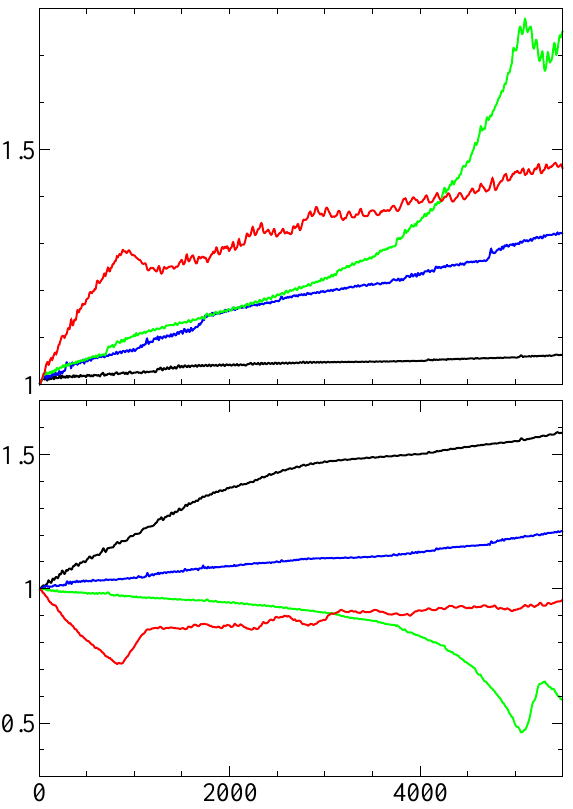
Fig. 4. Time variation of µ ⊥ (solid lines) and µ k (dashed lines), when fixing r L /l f and changing β . Top: r L /l f = 0 . 35 (red series of Fig. 1) with β = 0 . 075 (black), β = 0 . 3 (blue), β = 1 . 2 (green), and β = 2 . 4 (red). Bottom: r L /l f = 0 . 087 (orange series of Fig. 1) with β = 0 . 15 (magenta), β = 0 . 3 (blue), β = 1 . 2 (green), and β = 2 . 4